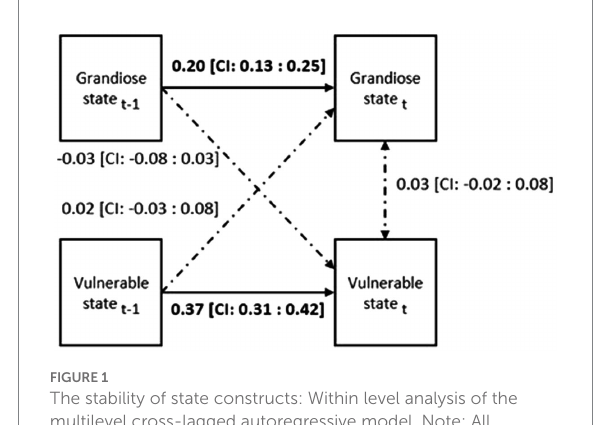
FIGURE 1 The stability of state constructs: Within level analysis of the multilevel cross-lagged autoregressive model. Note: All estimates are standardized, bold estimates are significant on p <0.001. CI: 95% credibility